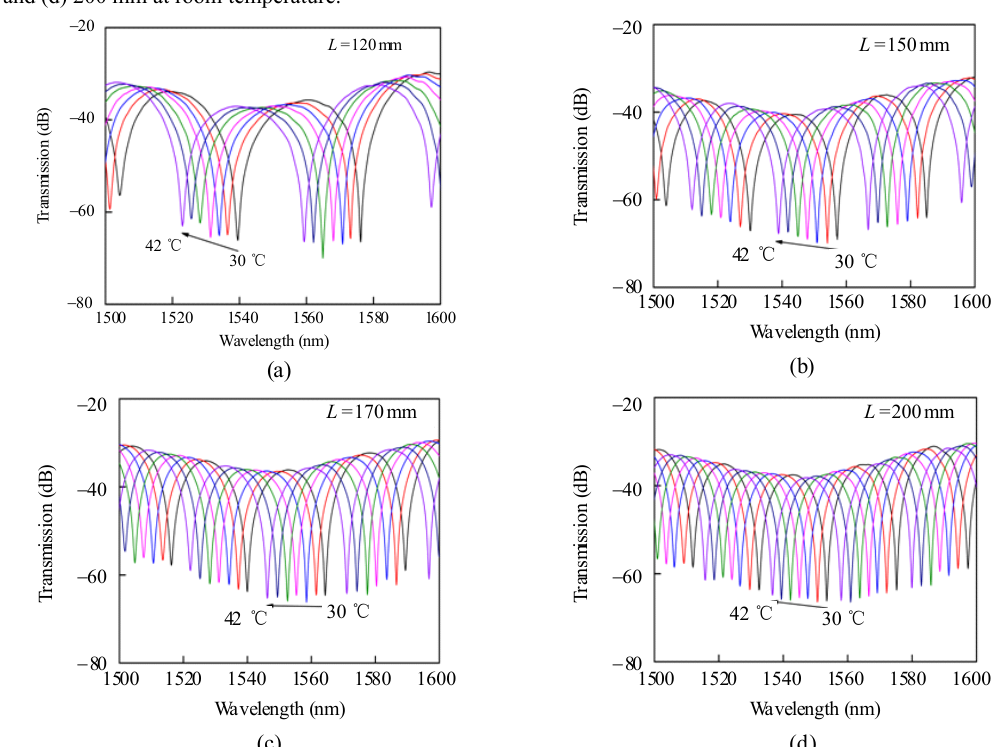
Fig. 3 Transmitted spectra shift of the PMF-based Sagnac interferometer with different PMF lengths of (a) 120 mm, (b) 150 mm, (c) 170 mm, and (d) 200 mm while the temperature rises from 30 ℃ to 42 ℃